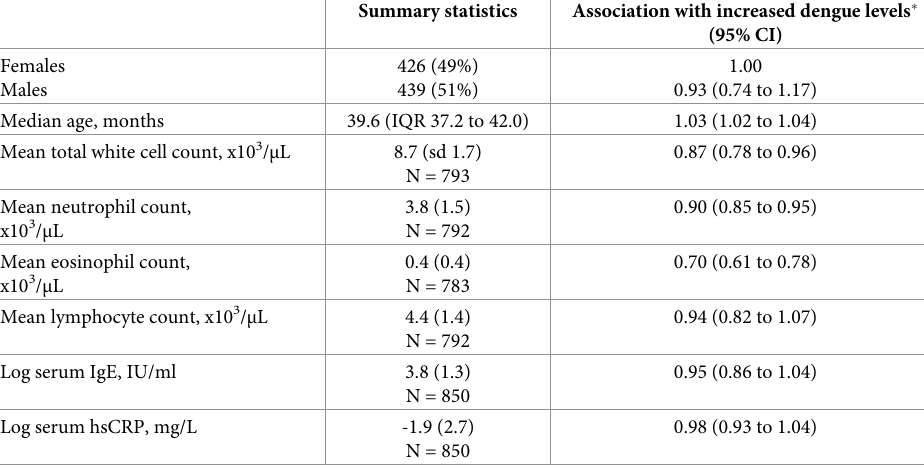
Table 1. Study population with associations with increased dengue IgG